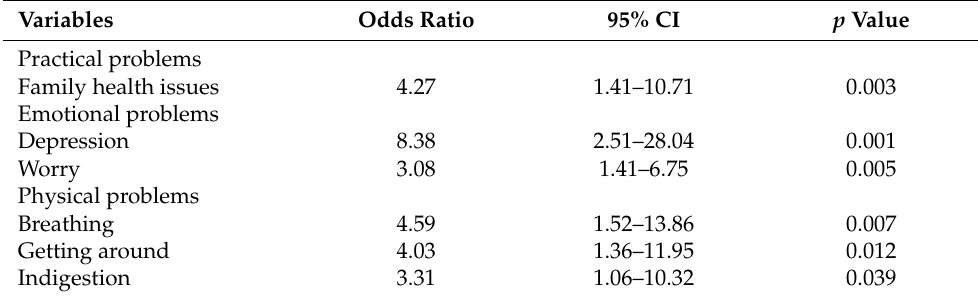
Table 5. Significant problems associated with distress ( N =